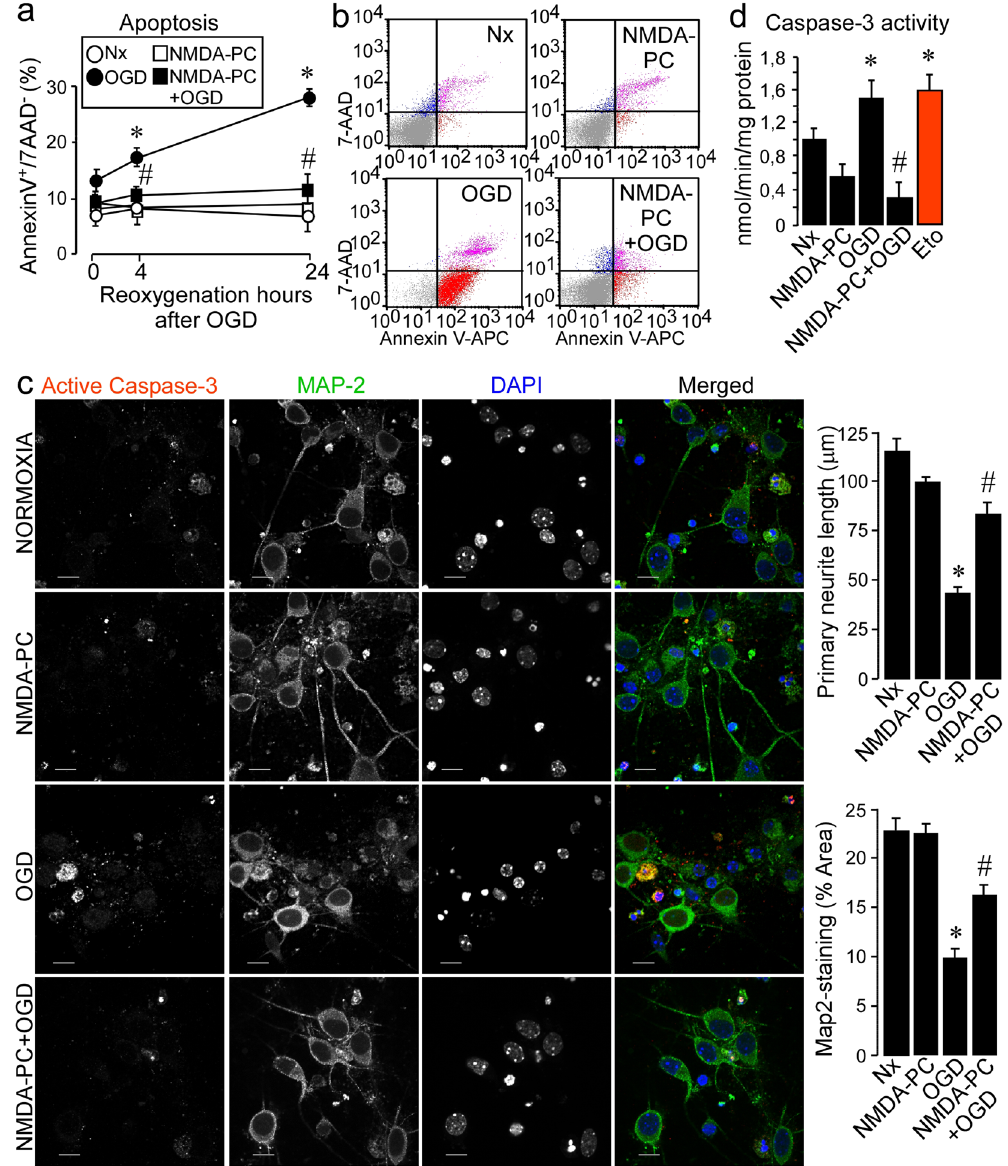
Figure 1. NMDA-PC prevents ischemia-induced neuronal apoptotic death. Mouse cortical neurons (9–10 DIV) were exposed to a validated in vitro model of NMDA-PC and neuronal apoptosis ( a , b ) was analyzed by flow cytometry. Annexin V-APC stained cells that were 7AAD negative were considered to be apoptotic (AnnexinV + /7AAD − ). ( a ) OGD induced neuronal apoptosis in a time-dependent manner, which was prevented by NMDA-PC. ( b ) Flow cytometry plots showed that NMDA-PC prevented OGD-induced neuronal apoptosis, as shown by the decrease in the percentage of apoptotic neurons (lower right, red), in comparison to OGD condition. ( c ) Immunofluorescence images, the primary neurites length and Map-2-staining area quantification revealed that NMDA-PC prevented neurite degeneration caused by ODG. Scale bar: 10 μ m. ( d ) NMDA-PC prevented the activation of caspase-3 induced at 4 hours after OGD, as revealed by both ( c ) immunostaining and ( d ) fluorimetry (Neurons treated with apoptosis inductor, 10 μ M etoposide for 24 hours were treated as control of apoptosis). Data are means ± S.E.M. (n = 5 independent neuronal cultures). Statistical analysis of the results was evaluated by one- way analysis of variance, followed by the least significant difference multiple range test. Student’s t-test was used for comparisons between two groups of values. In all cases, p < 0.05 was considered significant. * p < 0.05 versus Nx. # p < 0.05 versus OGD. Relative percentages of neurons with active caspase-3-staining/Map-2-staining are presented in Supplementary Fig.